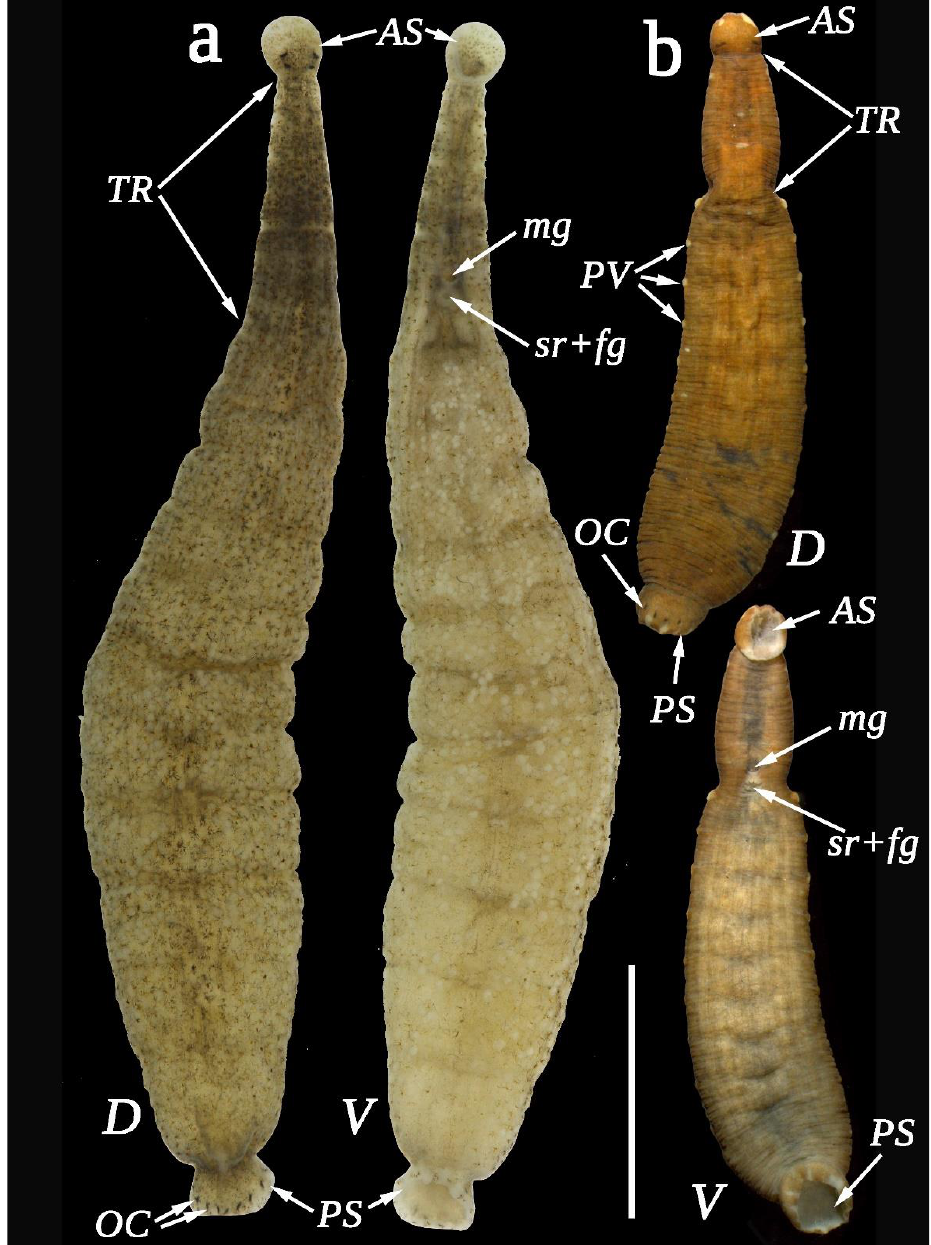
Figure 2. Dorsal ( D ) and ventral ( V ) view of Acipenserobdella volgensis (Zykoff, 1904) specimens. ( a ) Large adult specimen RMBH Hir_0189 from the mantle cavity of the duck mussel Anodonta anatina (Linnaeus, 1758) (Unionidae), Moscow River, European Russia. ( b ) Smaller sub-adult (immature) specimen RMBH Hir_0461_1 collected from stones, Moscow River, European Russia (sequenced). Abbreviations: TR , trachelosome (anterior part of the body); AS , anterior sucker; PS , posterior sucker; PV , pulsatile vesicles; OC , ocelli; mg , male gonopore; and sr + fg , seminal receptacle (spermatheca) opening with female gonopore. Scale bar = 5 mm. Photos: Tatyana A. Eliseeva.